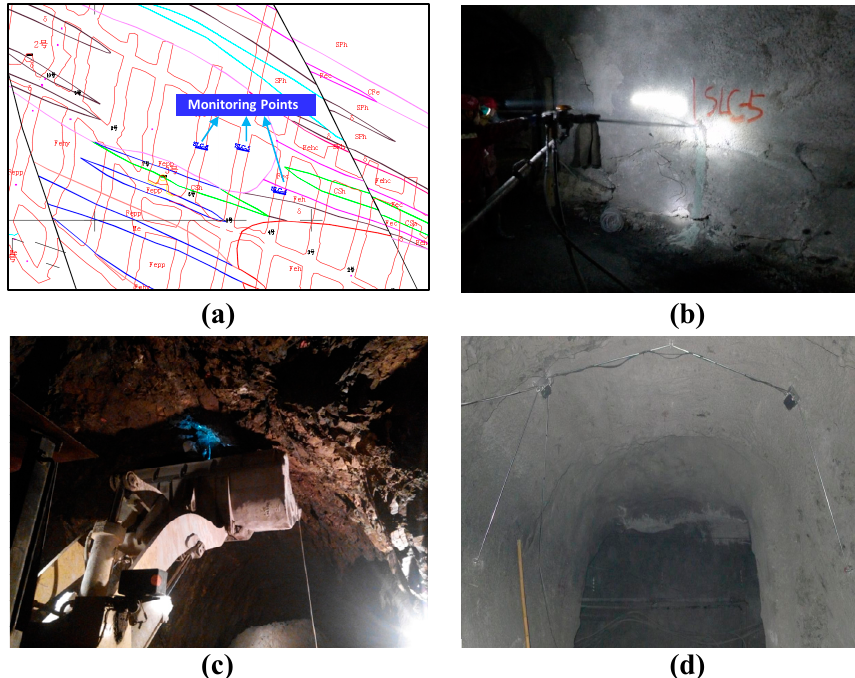
Figure 10. Engineering photos of ( a ) locations of monitoring points, ( b ) horizontal hole drilling, ( c ) vertical hole drilling, and ( d ) TSCCMS placement.